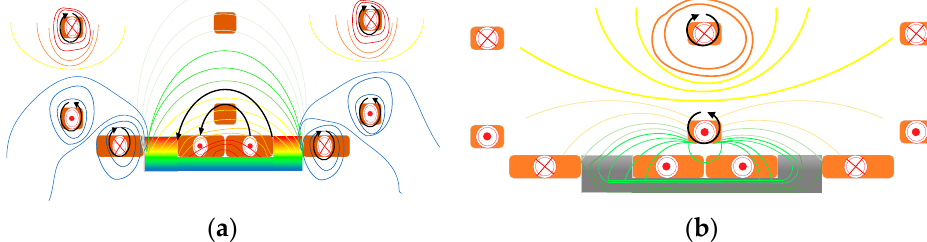
Figure 11. ( a ) Distribution of magnetic flux lines in the transmitting coil ( b ) Flux line distribution in the receiving coil.